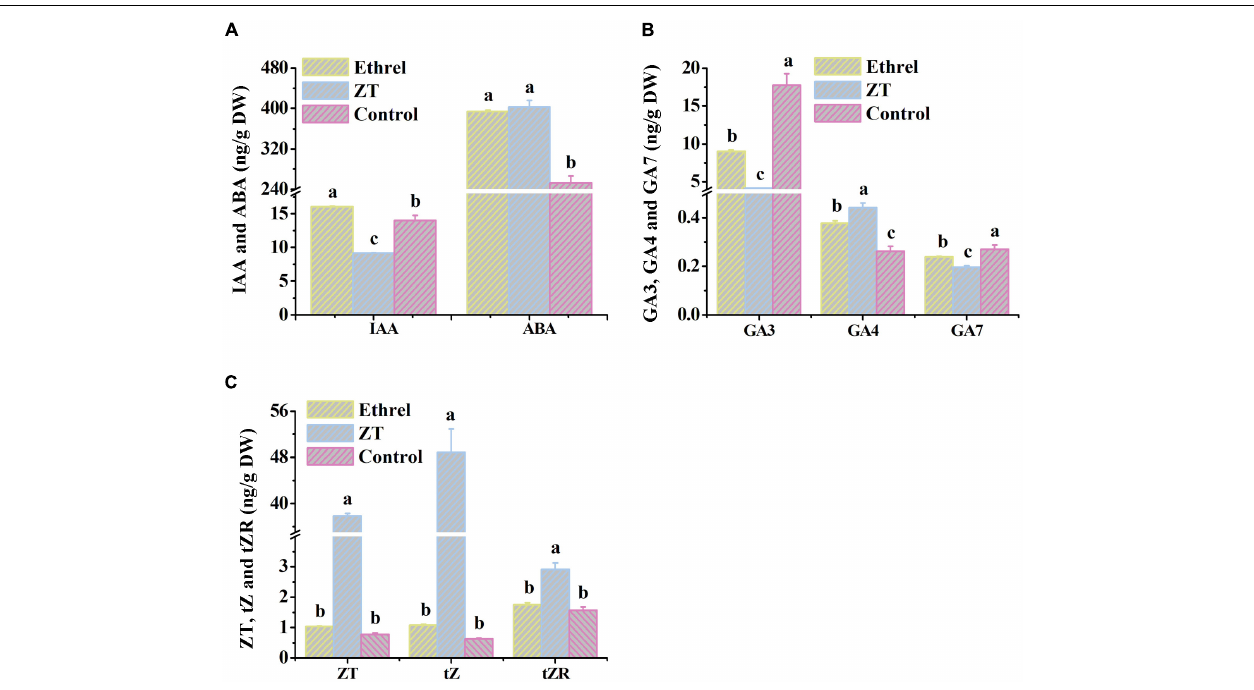
FIGURE 4 | Changes in endogenous hormone levels in androecious persimmon flowers in response to ethrel and ZT treatment. (A) Contents of IAA and ABA. (B) Contents of GA 3 , GA 4 and GA 7 . (C) Contents of ZT, tZ and tZR. Different letters denote significant differences among the treated and control groups (Tukey’s test, P <